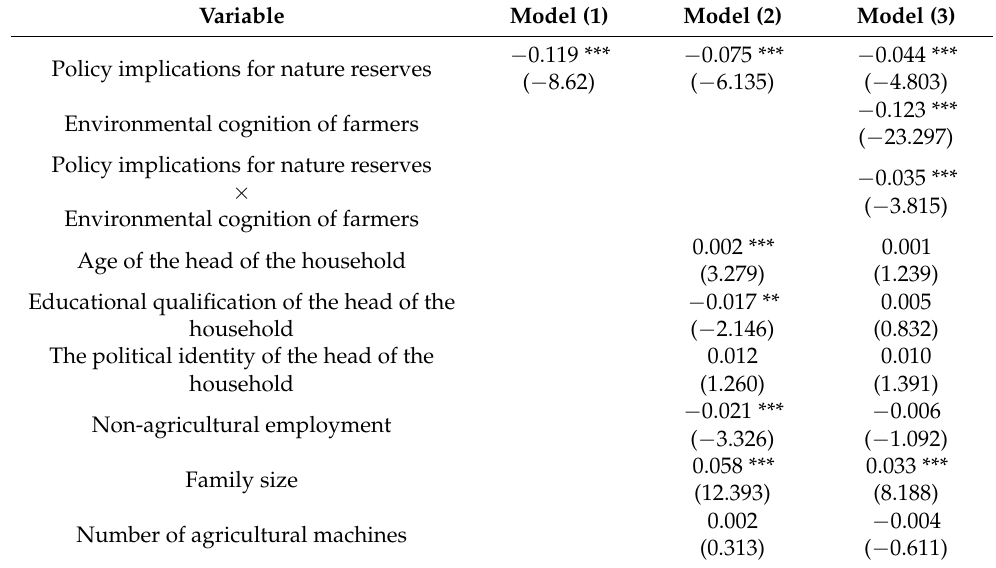
Table 4. OLS regression